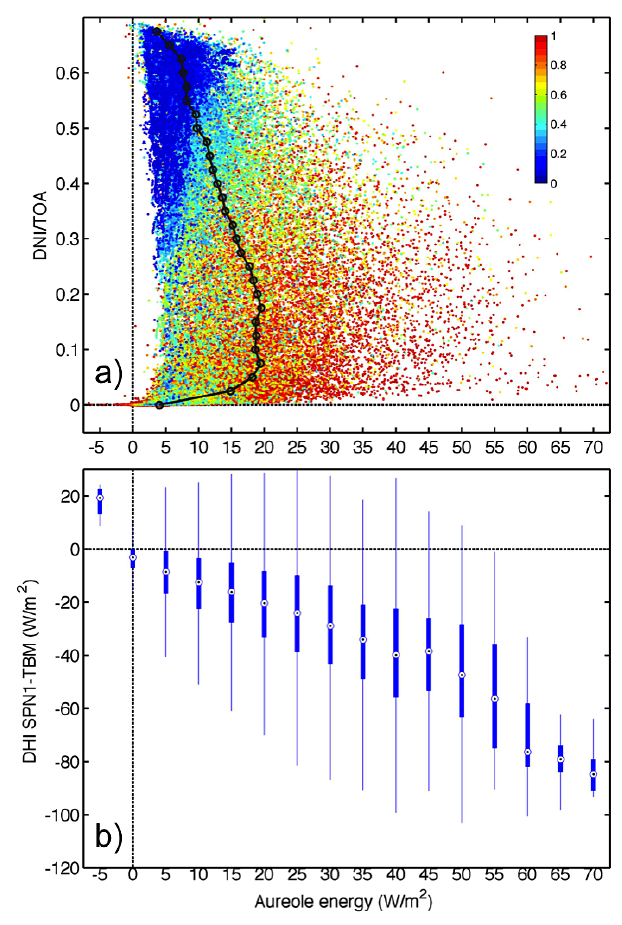
Figure 7. (a) DNI/TOA vs. aureole energy; colour scale corre- sponds to CF (CF = 0 in blue, CF = 1 in red). Black line represents the mean aureole values for each 0.025-wide bin of DNI/TOA. (b) DHI SPN1 – TBM differences in box plots as a function of aureole energy at Winster. Box sizes account for 25–75 percentile interval. Whisker length corresponds to approximately ± 2.7 σ and 99.3% coverage if the data are normally